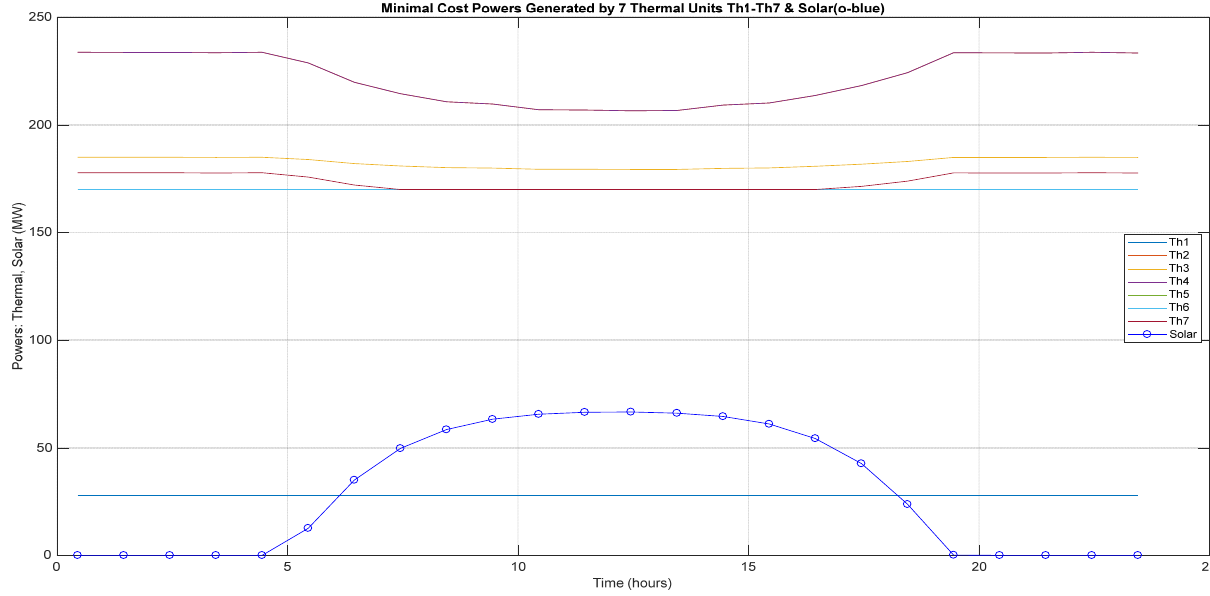
Figure 5. Constrained minimal cost generated powers [ P λ ] by thermal units Th1–Th7 and solar power CSP unit from λ = 175.95 to λ = 174.71, over 24 h. The outputs of Th2 and Th4 are equal (shown superposed). The outputs of Th5 and Th6 are equal as well (superposed). The output of Th7 is equal to Th5 and Th6 between hours 6:45–17:45 (partly superposed).